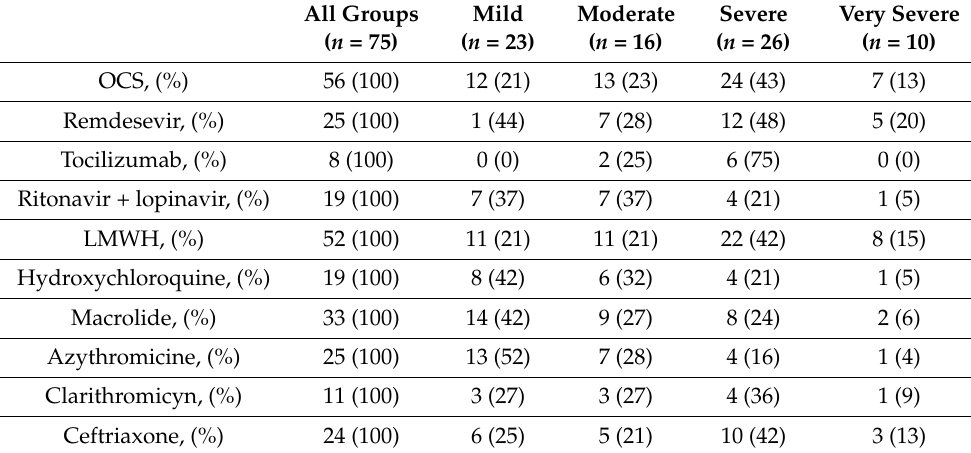
Table 3. Therapies used for SARS-CoV-2